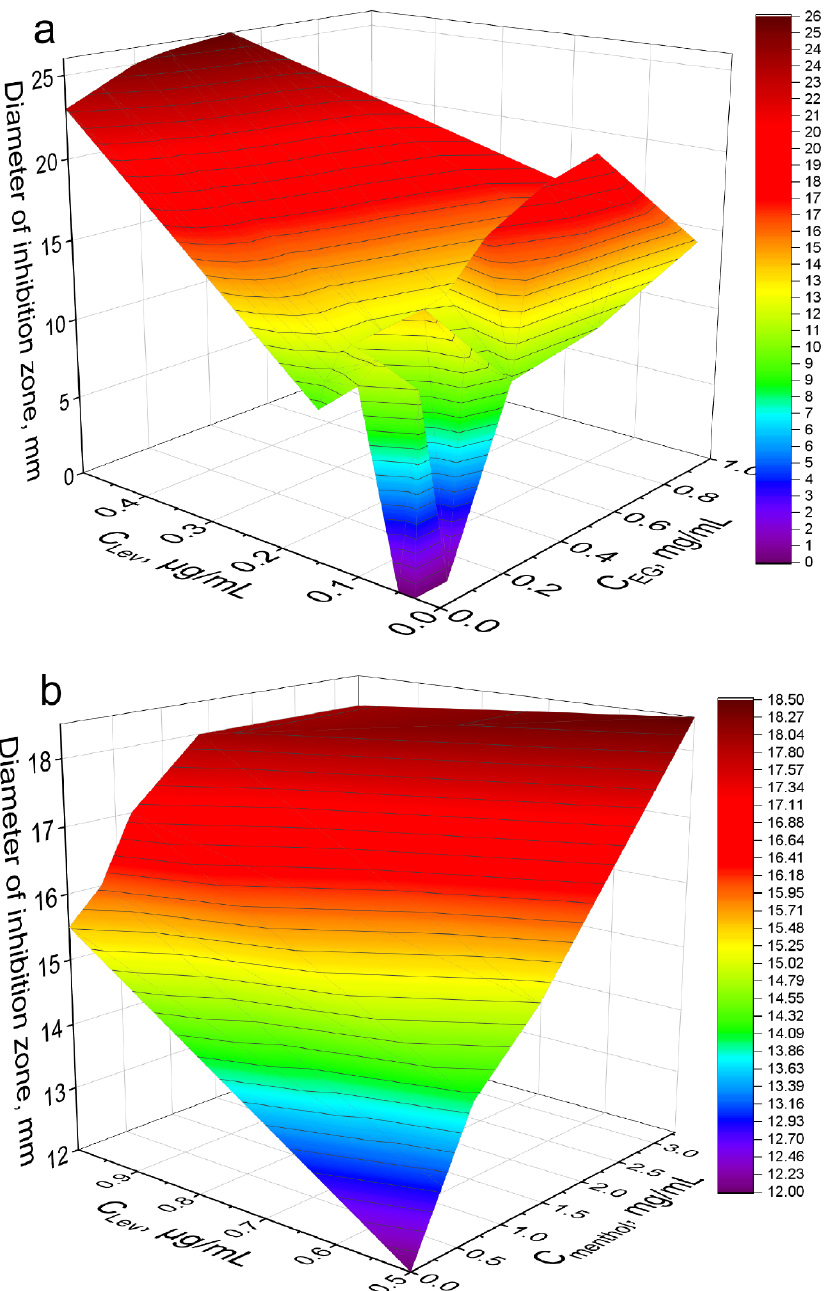
yellow area—weak inhibition, orange—medium, red—significant inhibition. MIC of Lev- MCD on E. coli was reduced from 0.06 to 0.015–0.02 μ g/mL due to introduction of 1 mg/mL of the adjuvant EG-MCD. At minimal Lev concentrations the greatest adjuvant effect of EG (a 3-fold amplification effect) is achieved due to synergism.